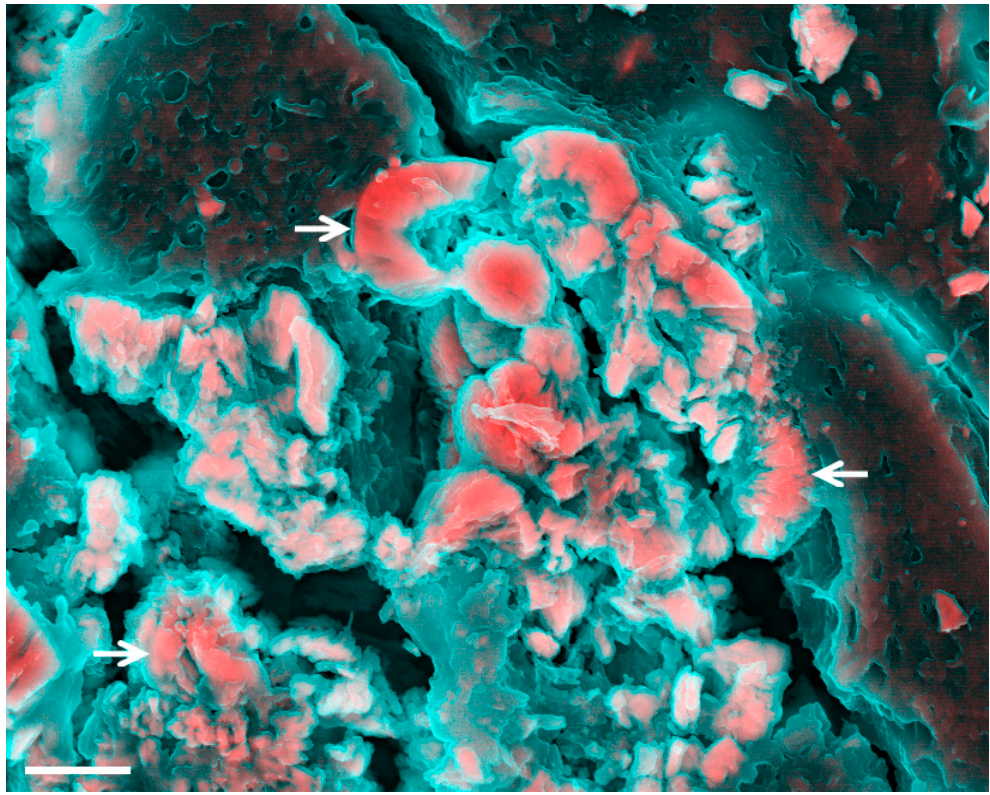
Figure 3. Density-dependent colour-scanning electron micrographs of kidney stones. Red and pink indicate inorganic and turquoise (blue/green) indicates organic material. Electron micrograph of mineral found in the kidney (arrows) [145]. Scale bar = 2 µm.